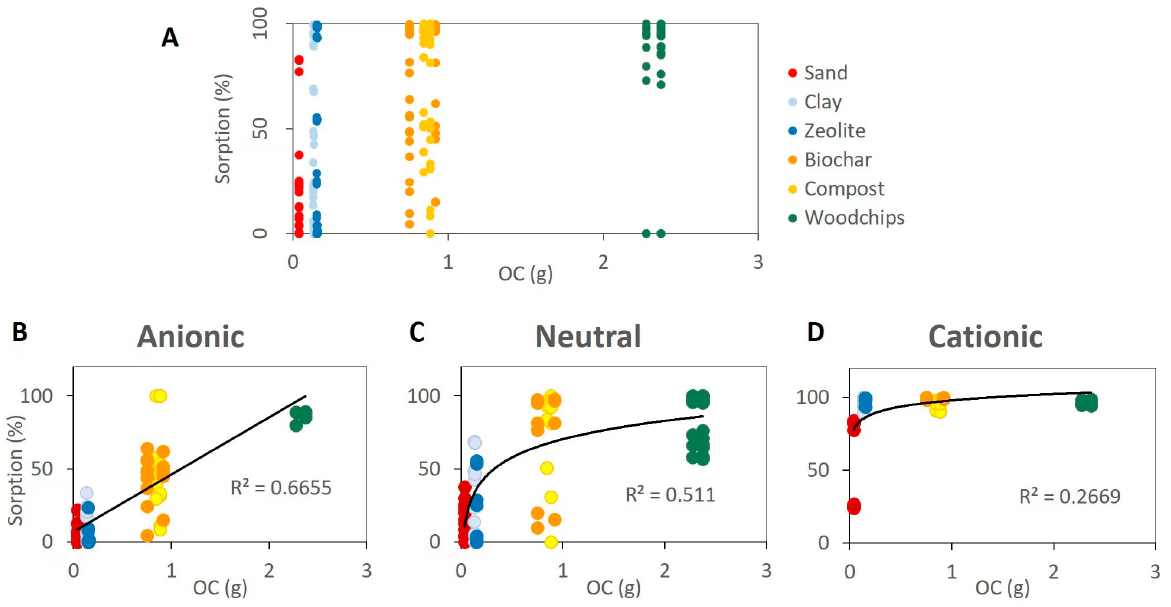
Figure 5. Sorption versus the amount of OC(g) ( A ) for each batch experiment and a linear fit for anionic ( B ) and logarithmic fi t for neutral ( C ) and cationic ( D ) species.